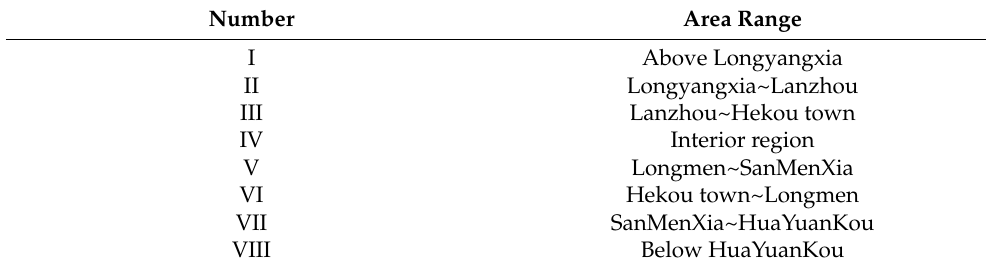
Table 1. Range of eight sub-regions.